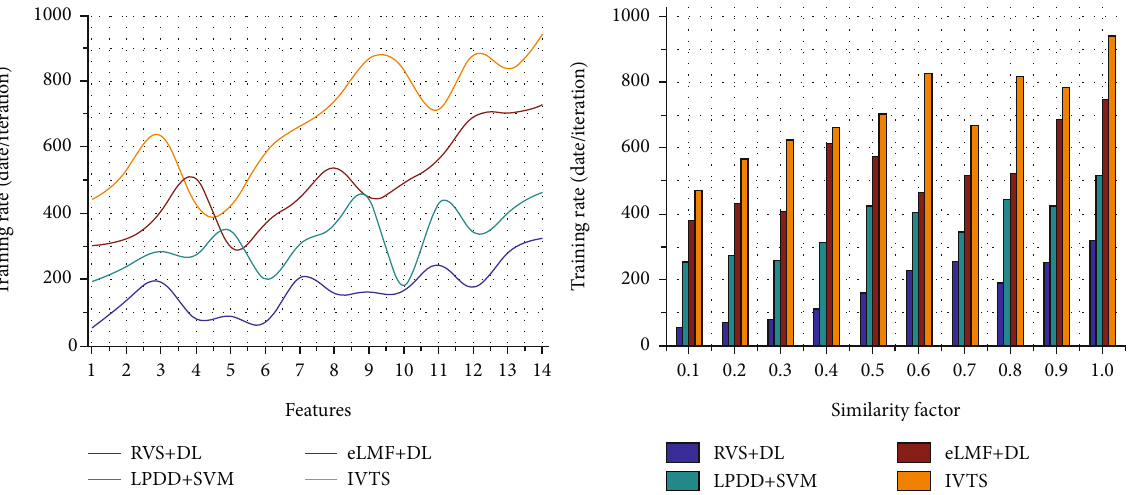
Figure 10: Training rate